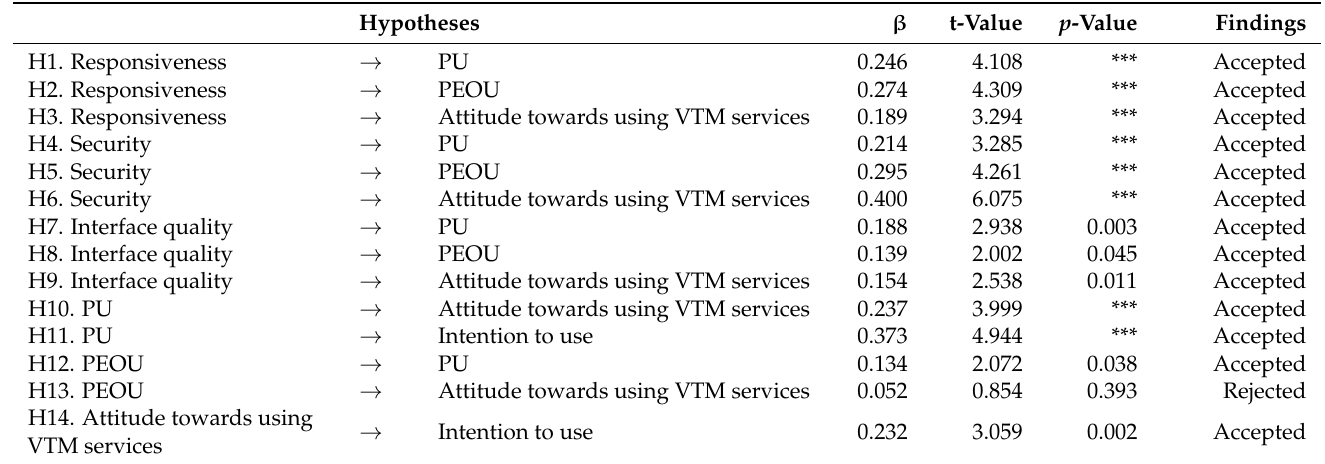
Table 4. Hypothesis testing results.